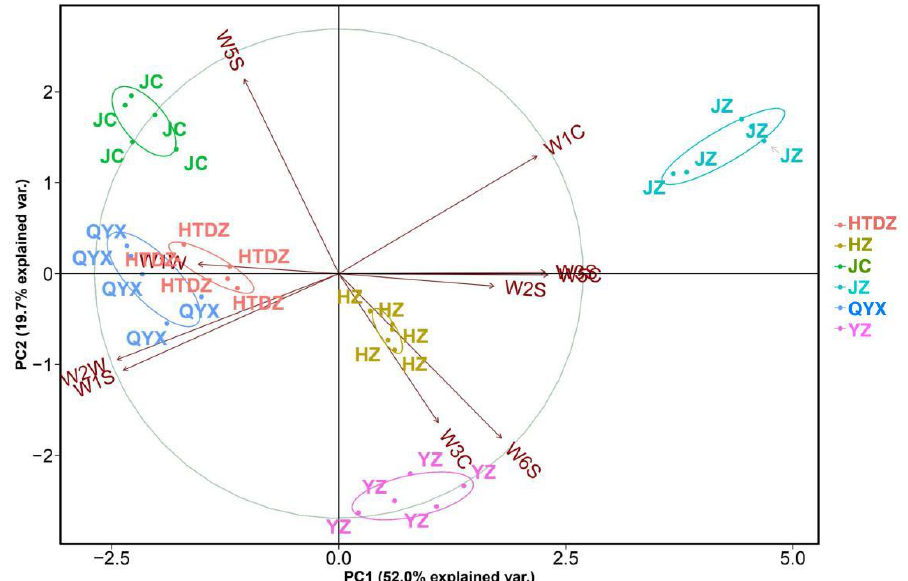
Figure 2. Principle component analysis (PCA) and loading plot of E- nose data for the six red jujube cultivars in Xinjiang Province, China (Jinchang—‘JC’, Junzao—‘JZ’, Huizao—‘HZ’,Qiyuexian—‘QYX’, cultivars in Xinjiang Province, China (Jinchang —‘JC’, Junzao—‘JZ’, Huizao—‘HZ’,Qiyuexian— Hetiandazao—‘HTDZ’, and ‘QYX’, Hetiandazao—‘HTDZ’, and Yuanzao—‘YZ’) .